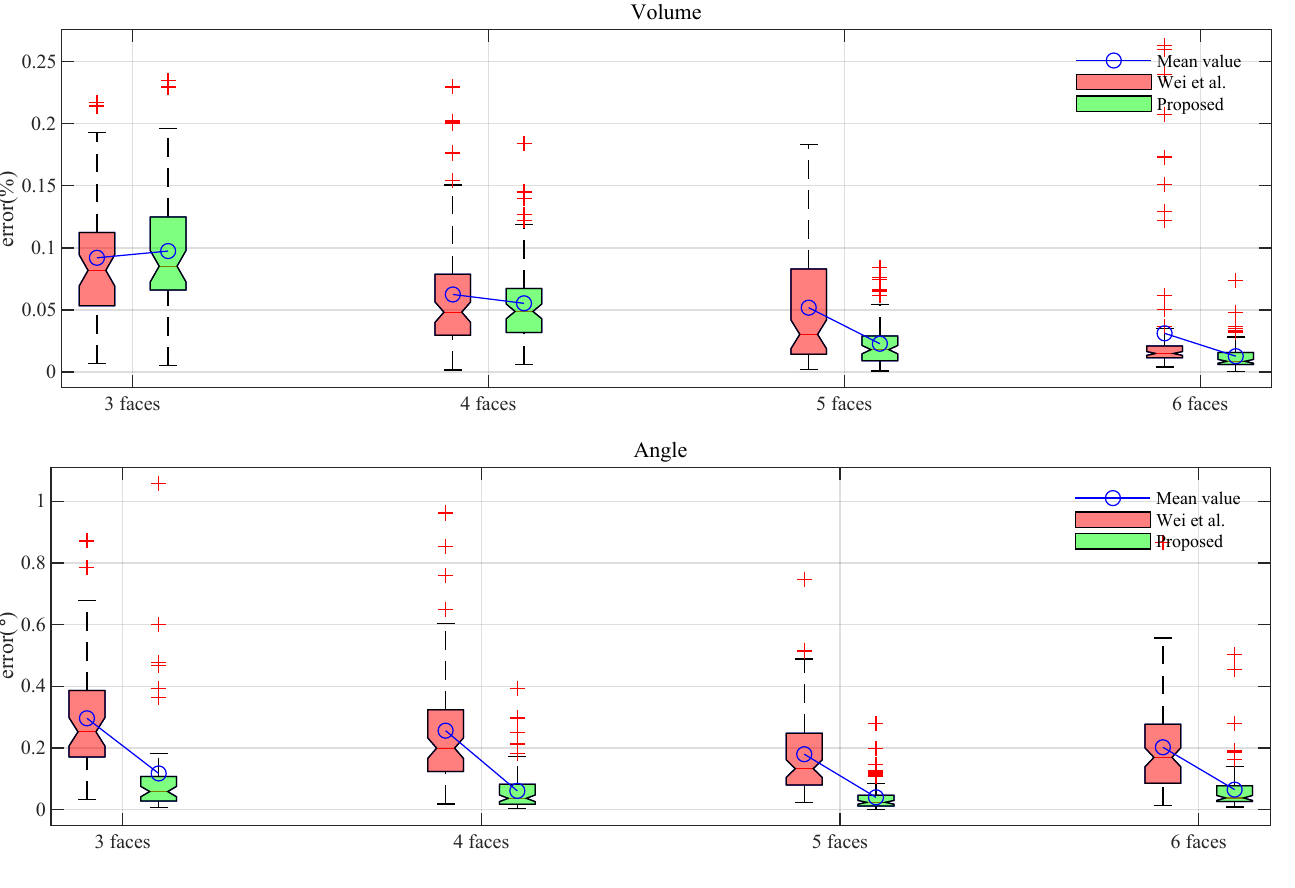
Figure 7. Boxplot of results reported in Table 3. Symbols representing method of Wei et al. [10] and proposed method are colored in red and green, respectively. Mean errors of two methods are denoted as blue lines with circle markers, respectively, to visualize results reported in Table